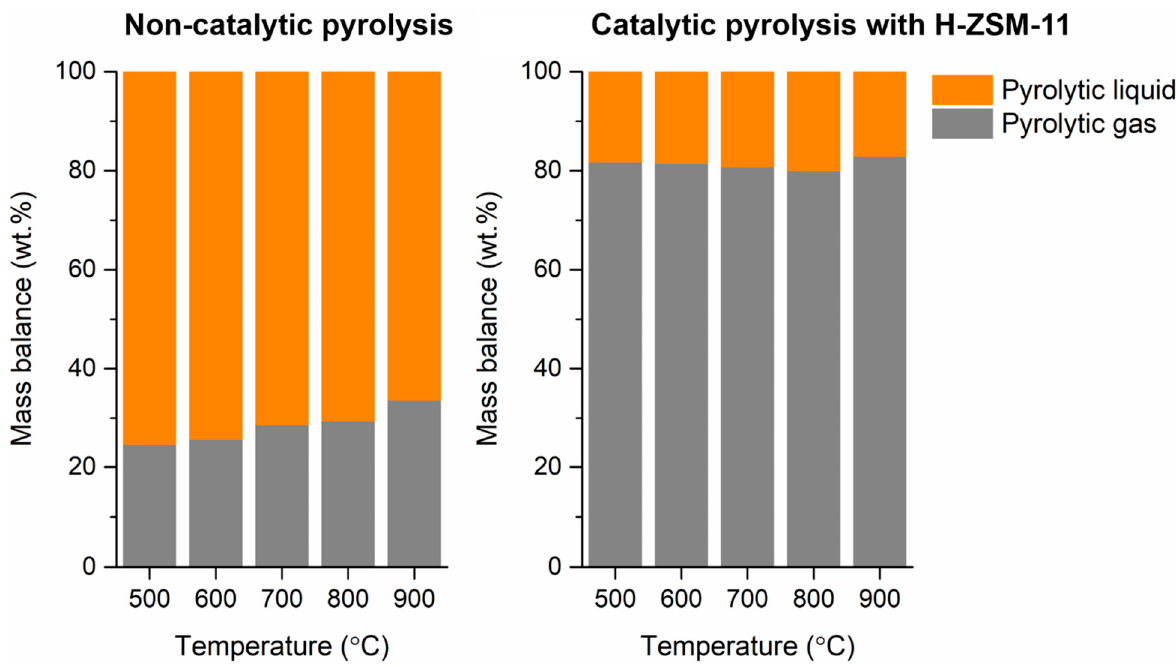
Figure 2. Overall mass balances of pyrolytic products produced via the pyrolysis of LDPE without and with the H-ZSM-11 catalyst as functions of pyrolysis temperature. Average values of triplicates ( n = 3) are reported and standard deviations of the average values of around 3–6%.